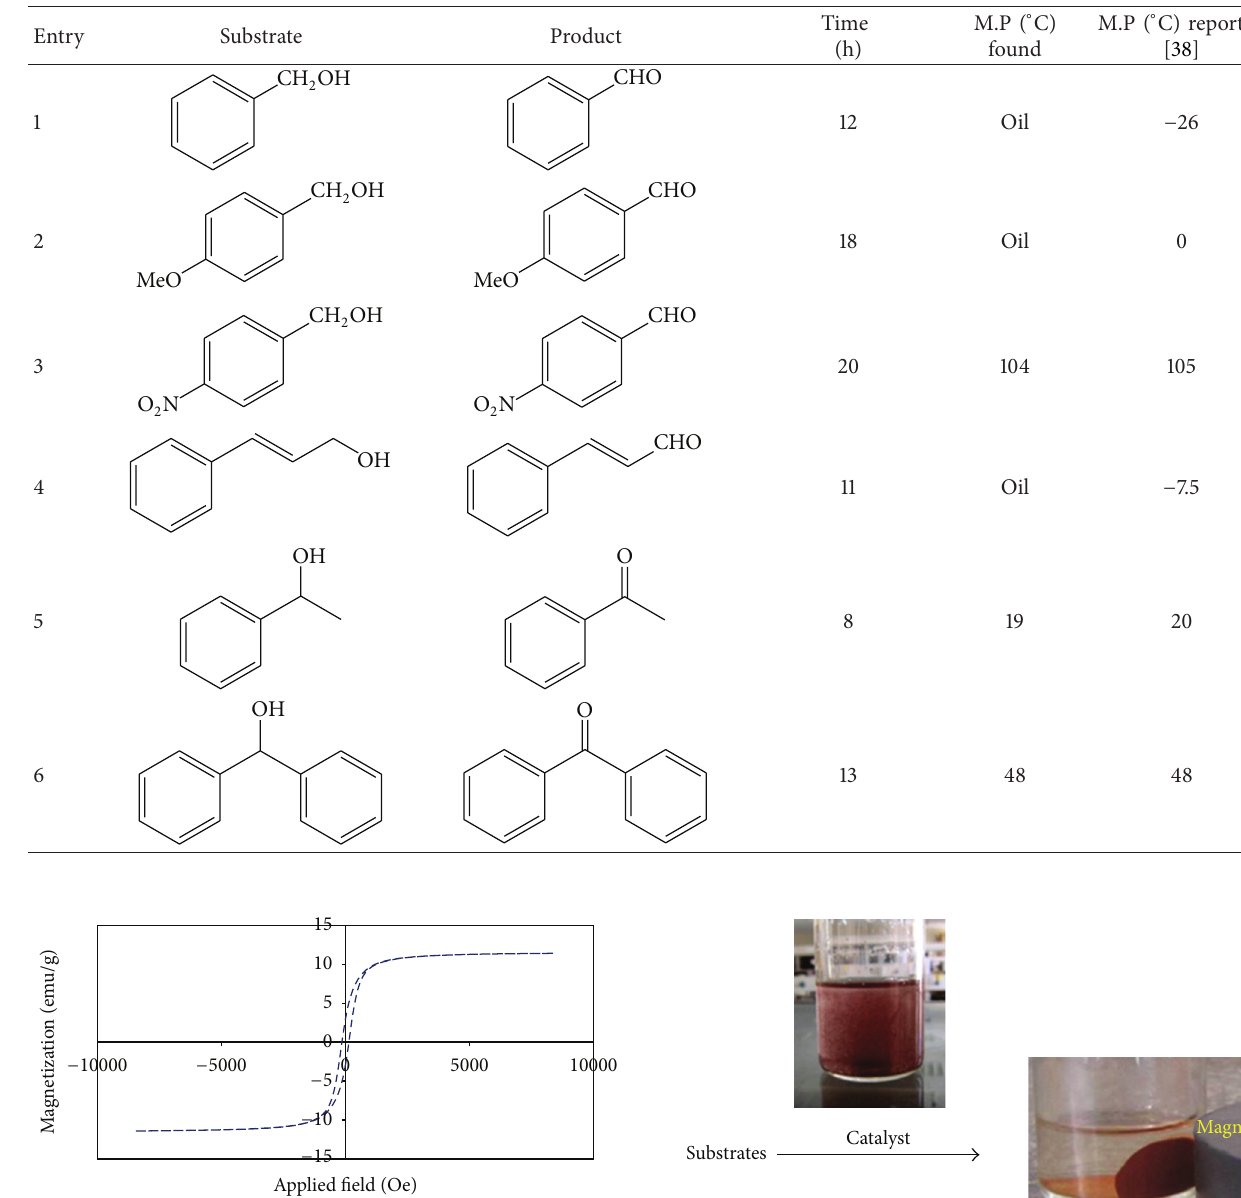
Table 3: Catalyzed oxidation reactions.